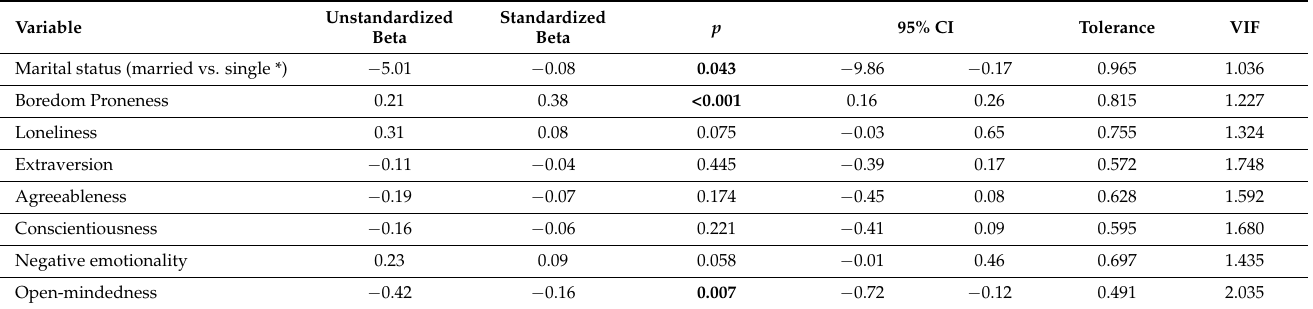
Table 4. Linear regression of factors associated with the generic scale of phubbing score taken as the dependent